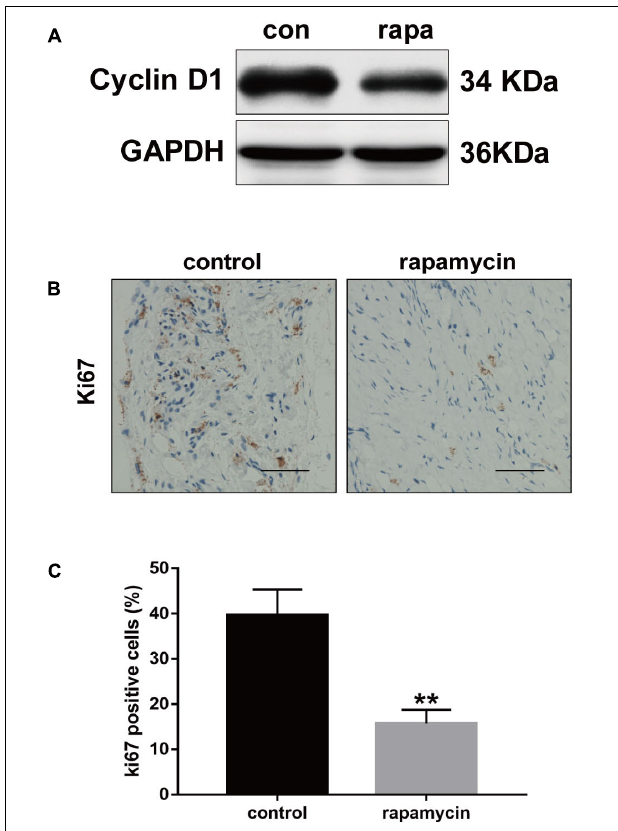
FIGURE 5 | Rapamycin inhibits excessive proliferation after tendon injury. (A) Representative images of western blot analysis of Cyclin D1 after DMSO or rapamycin treatment. (B) Representative images of Ki67 staining and (C) quantitative analysis after different treatments. Scale bar: 50 µ m. n = 5 in each group. The data are shown as the means ± SD. ∗∗ P < 0.01 compared with the control